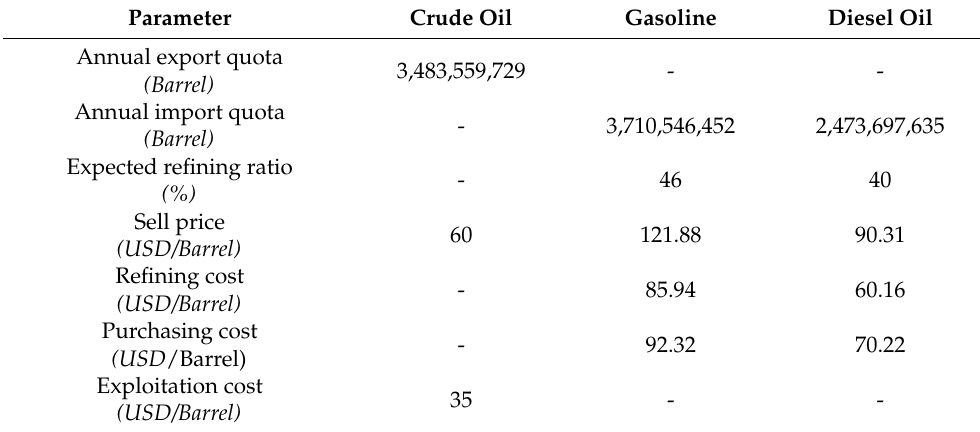
Table A3. Product-related parameter value.